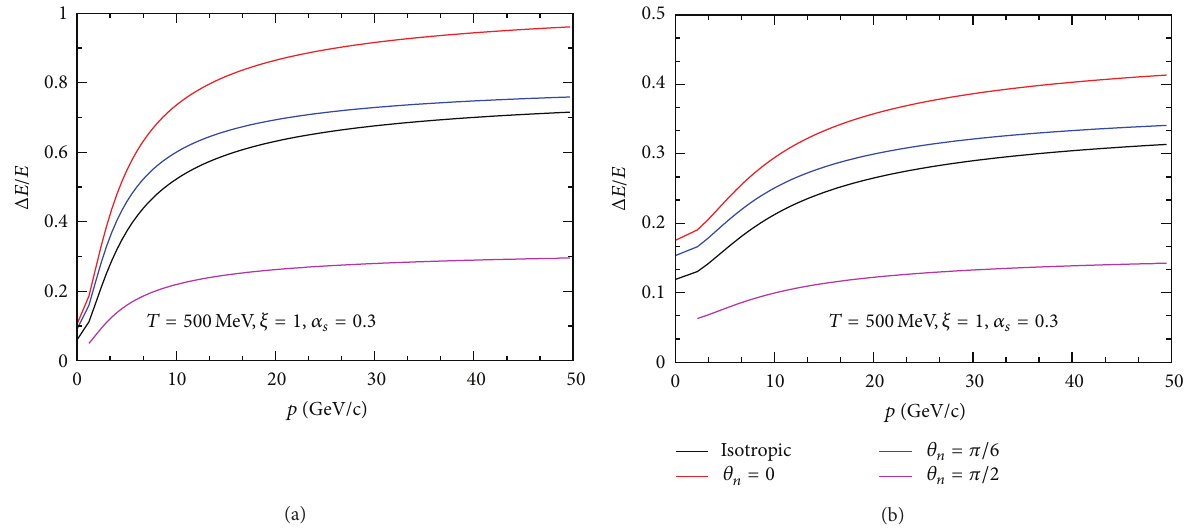
Figure 8: (Color online) Same as 7 for charm quark (a) and bottom quark (b) with 𝜉 = 1 and 𝑇 = 500 MeV.